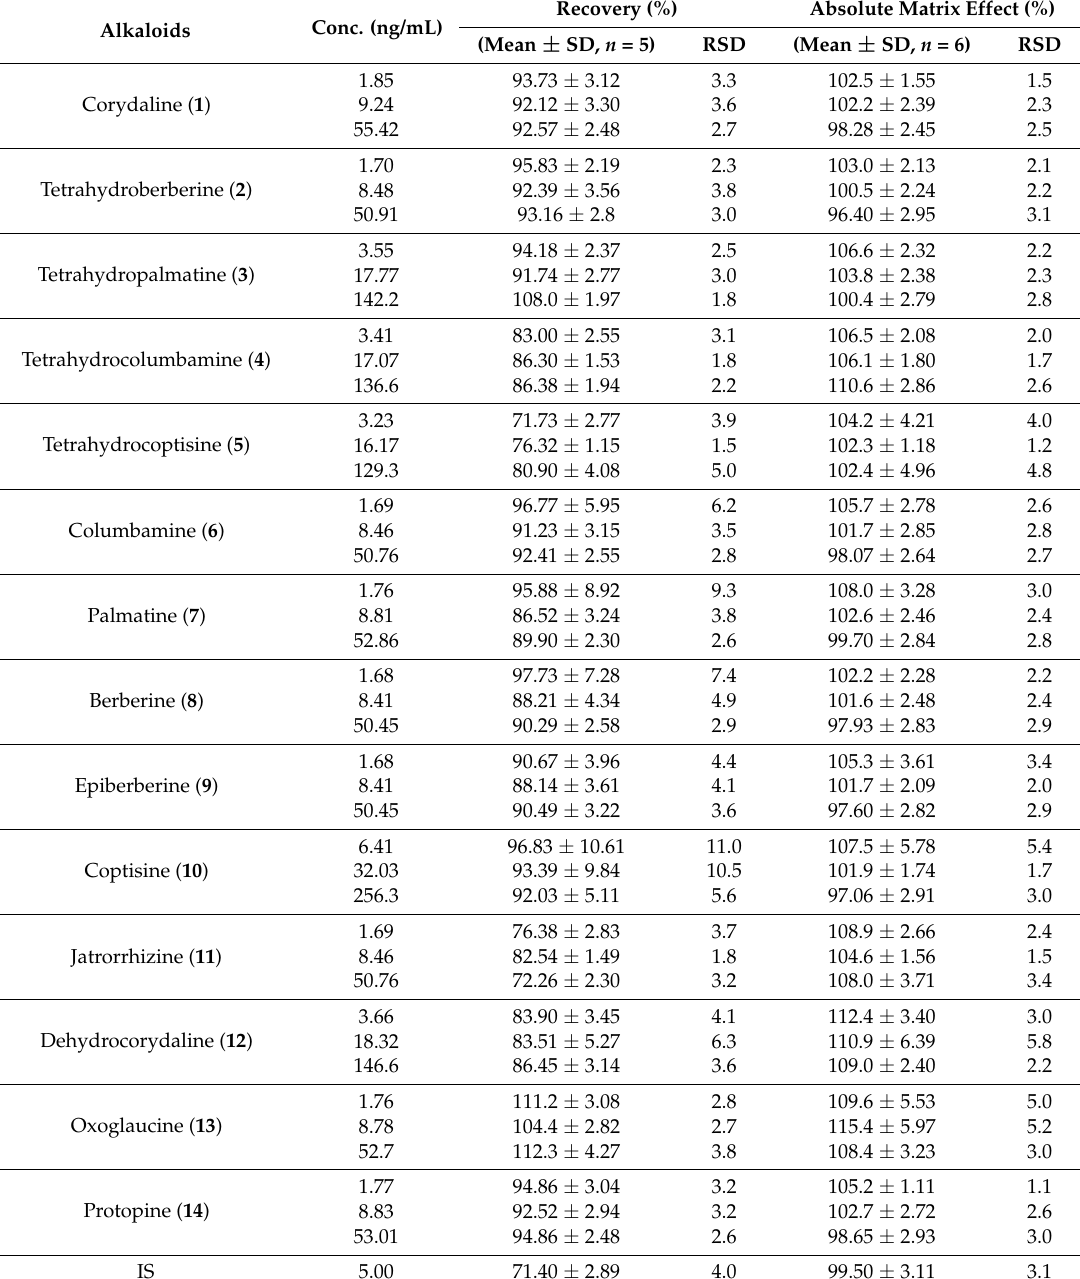
Table 4. Matrix effects and extraction recoveries of the fourteen alkaloids in mouse